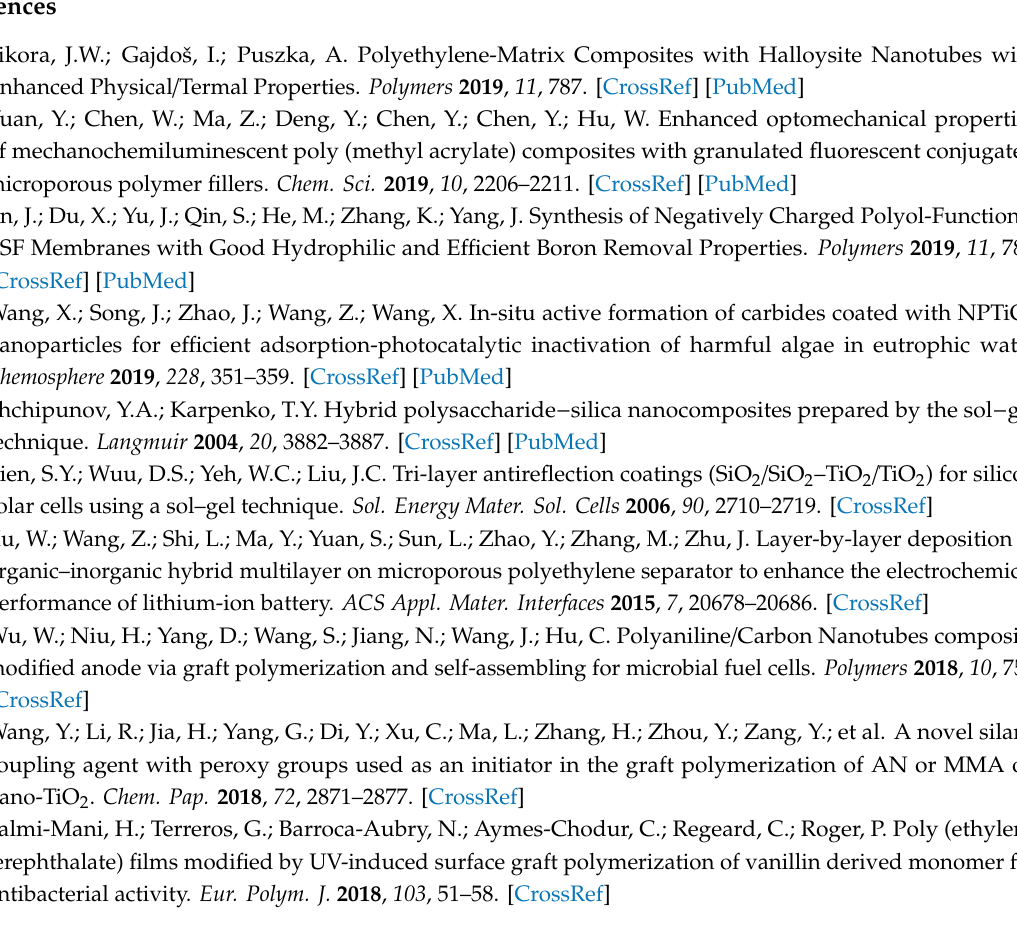
Table S1: Molecular weight and distribution of PS in